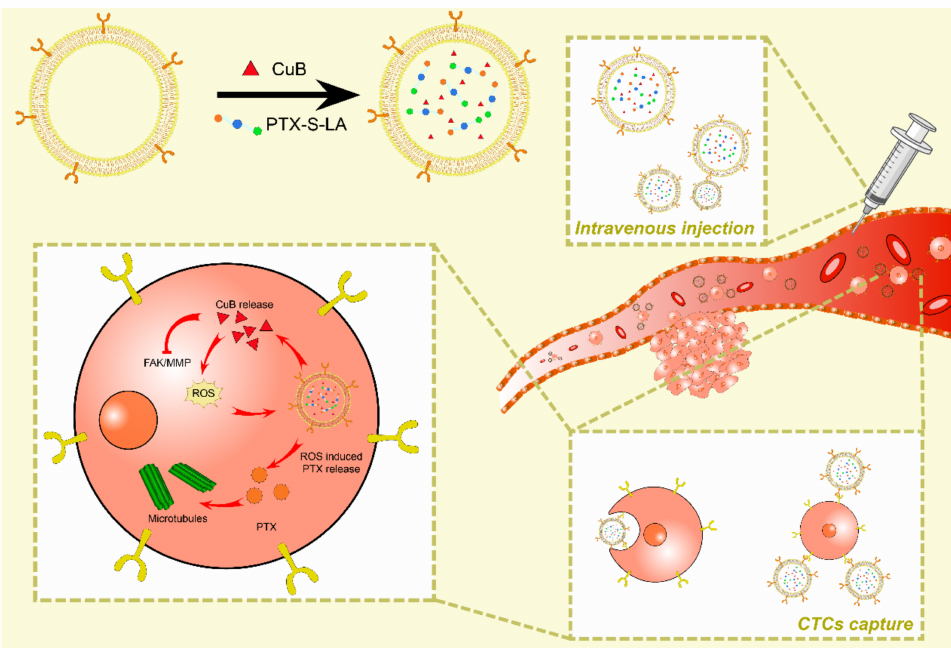
Figure 5. Exosomes from tumors have related proteins that can mediate homologous targeting on the surface. After loading CuB and PTX-S-LA into the exosomes. The exosomes can achieve targeted capture of homologous proteins with CTCs after intravenous injection into the blood. After exosome uptake by CTCs, CuB targeted FAK/MMP pathway in CTCs is released to inhibit tumor metastasis, and ROS is also released, which promotes sequential activation of PTX-S-LA and releases PTX to inhibit tumor